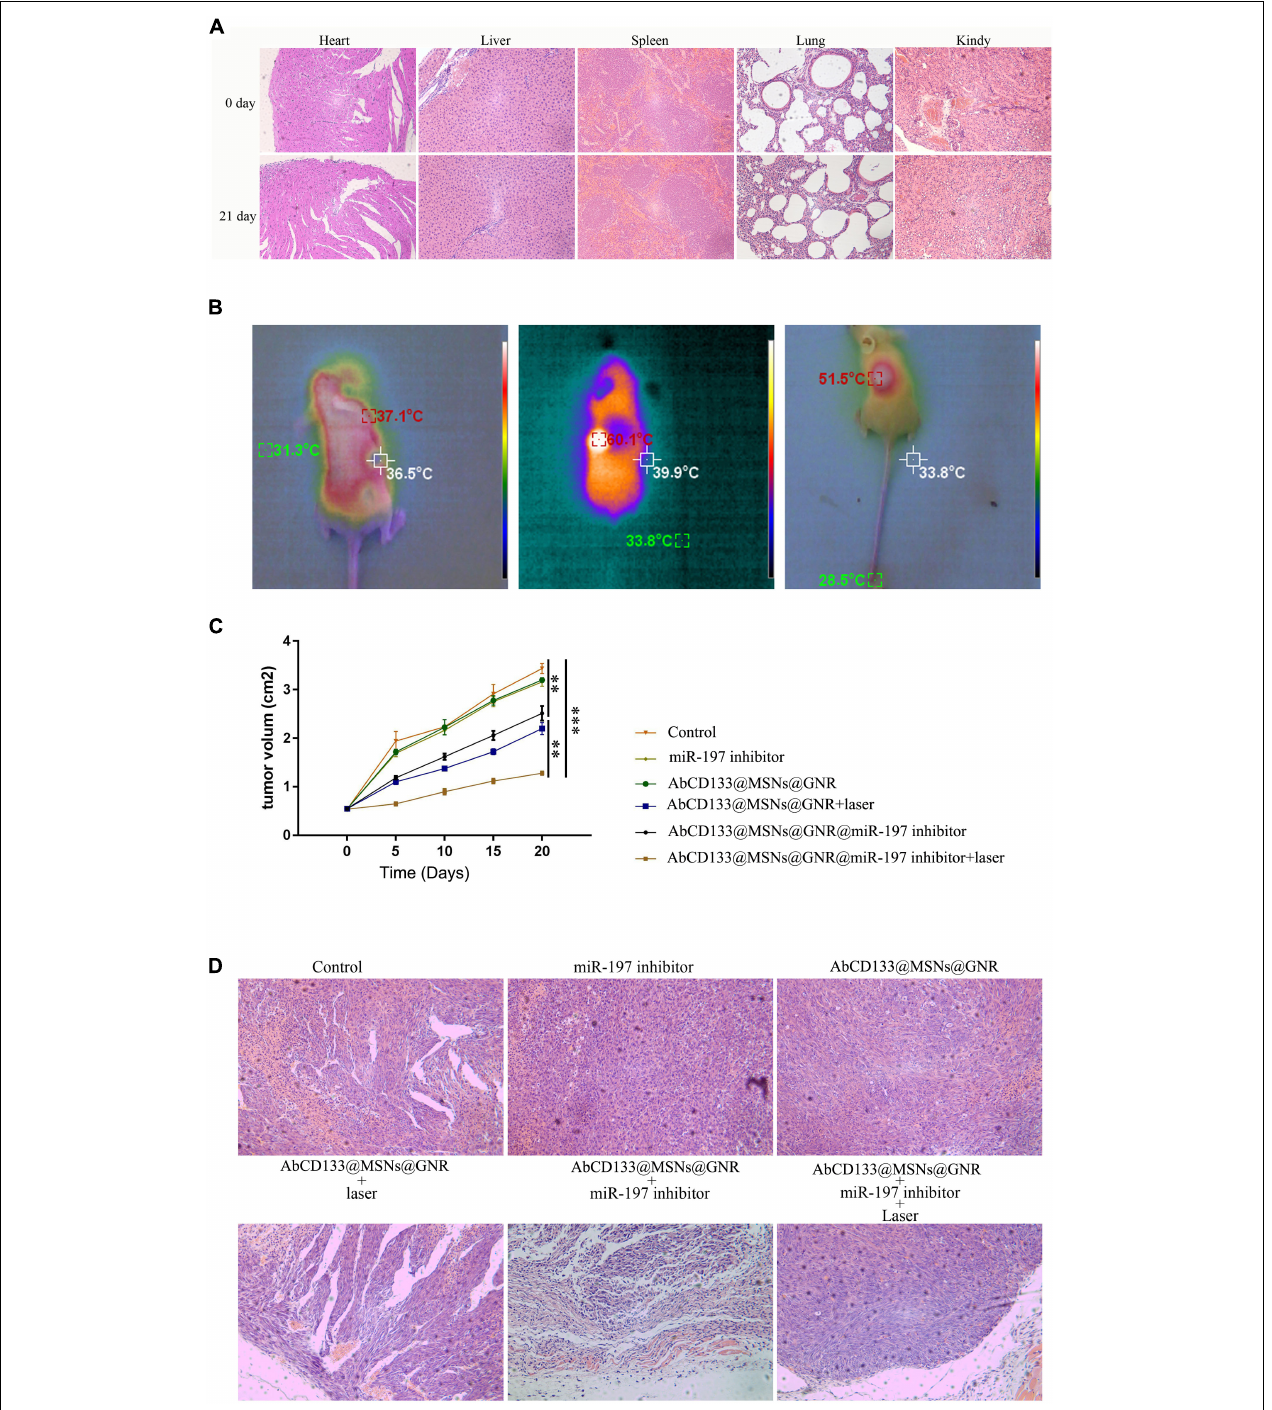
FIGURE 7 | The effect of AbCD133@GNR@MSNs@miR-197 inhibitor on prostate cancer stem cells (PCSCs) in a solid tumor model under 808-nm laser irradiation. (A) The acute toxicity of AbCD133@GNR@MSNs on the mice was determined using H&E staining assay to observe the effect of AbCD133@GNR@MSNs on the heart, liver, spleen, lung, and kidneys of the mice. (B) AbCD133@GNR@MSNs@miR-197 inhibitor could increase the temperature of the PCSCs in the solid tumors under 808-nm laser irradiation. (C) AbCD133@GNR@MSNs@miR-197 inhibitor could significantly inhibit the growth of the PCSCs in the solid tumors. (D) H&E staining assay was conducted to observe the effect of AbCD133@GNR@MSNs on the PCSCs in solid tumors under 808-nm laser irradiation. * p < 0.05, ** p < 0.01, *** p < 0.001.